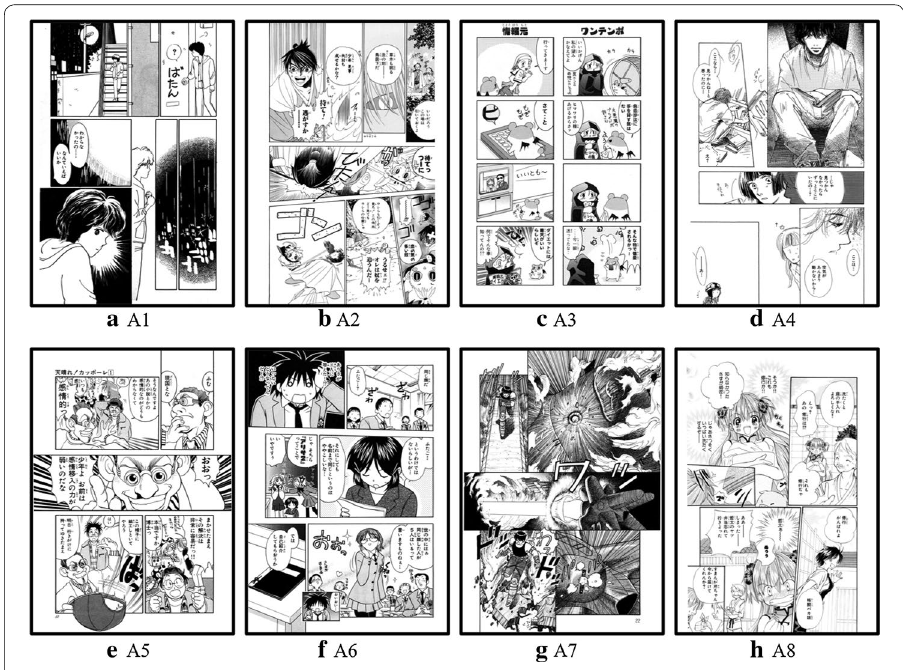
Fig. 1 Selected eight comic books for the classification of comic artist styles